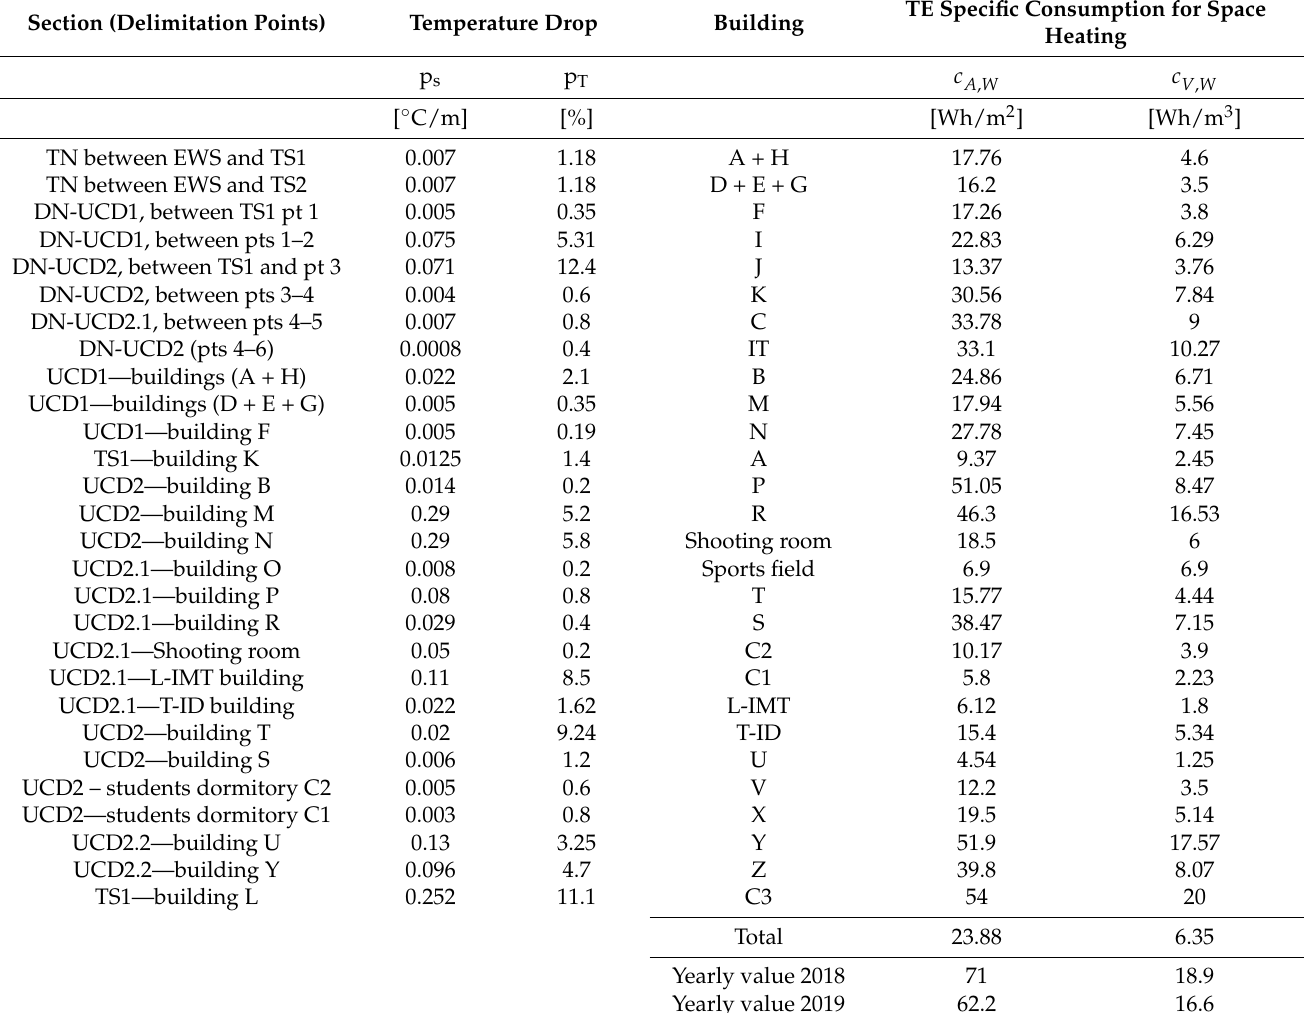
Table 13. Supply pipe temperature drop (hourly load) and TE specific hourly consumption for